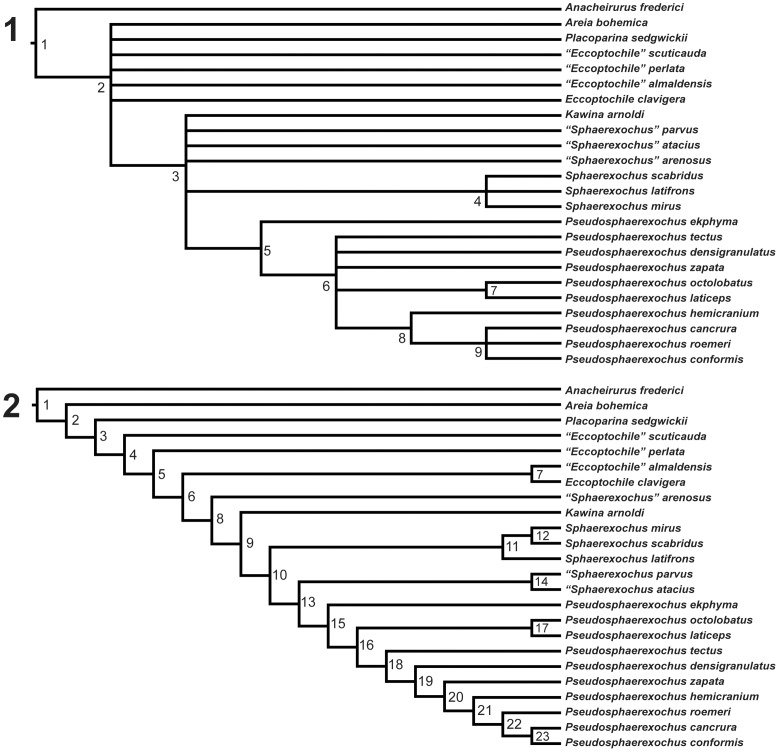
A strict consensus and one of fourteen most parsimonious trees.1, Results from parsimony analysis showing strict consensus of fourteen most parsimonious trees of length 119 steps. Tree graphics generated using FigTree v.1.3.1 [26] with genera labeled and paraphyletic genus identified using quotations following Wiley [27]. The following nodes of the tree were supported by the following jackknife confidence values (see text for jackknife procedure utilized): Node 2 = 100; Node 3 = 78; Node 4 = 92; Node 5 = 49; Node 6 = 30; Node 7 = 30; Node 8 = 42; Node 9 = 56. The following nodes of the tree were supported by the following bootstrap confidence values (see text for bootstrapping procedure utilized): Node 2 = 100; Node 3 = 29; Node 4 = 57; Node 6 = 7; Node 7 = 2; Node 8 = 8; Node 9 = 18.; 2, One of fourteen most parsimonious trees of length 119 steps. Most parsimonious character state reconstructions are: Node 1∶14[0,1,2]; 15[0,1]; 19[0,1]; 20[0,1]; 24[0,1]; 26[0,1]; 28[0,1]; 30[0,1]; 32[0,1]. Node 2∶19(1); 20(1); 26(1); 30(1); 32(1). Node 3∶1(1); 14(2); 31(1); 34(1). Node 4∶4(1); 8(1). Node 5∶13(1); 23(1). Node 6∶25(1); 28(0); 30(2). Node 8∶2(1); 3(1); 4(2); 5(1); 7(1); 10(1); 15(0); 18(1); 20(0); 21(1). Node 9∶27(1). Node 10∶6[0,2]; 12[0,1]; 31(0); 34(0). Node 11∶6(2); 12(1); 14(3); 33(1). Node 13∶16(1); 30(0); 32(0). Node 14∶6(2); 10(0). Node 15∶9(1); 11(1); 12(1); 18(0); 23(0); 25(0); 27(0). Node 16∶29(1); 30(3); 31(2); 32(2); 33(2); 34(2). Node 17∶14(0). Node 18∶26(0). Node 19∶11(0), 25(1). Node 20∶13[0,1]; 23(1). Node 21∶6(1); 10(0); 12(0). Node 22∶11(1); 17[0,1]; 19[0,1]. Node 23∶9(0); 13(0); 21(0); Parentheses denote unambiguous optimizations and brackets denote ambiguity.